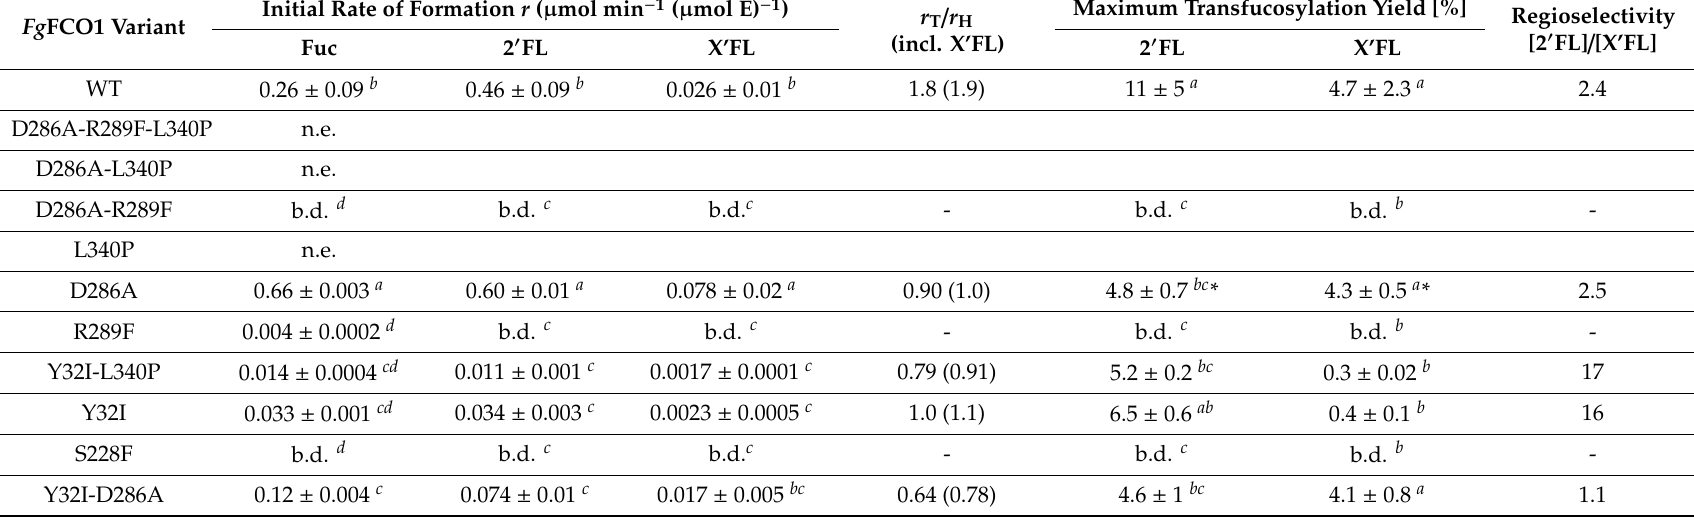
Table 2. Transfucosylation with rationally designed variants of Fg FCO1. Initial rates of formation ( r ) of fucose (Fuc), 2 (cid:48) -fucosyllactose (2 (cid:48) FL), and its regioisomer X’FL in the transfucosylation catalyzed by Fg FCO1 variants using fucosylated citrus peel xyloglucan as the fucosyl donor and lactose as the acceptor over 24 h. The ratio between the transfucosylation rate ( r T ) and the hydrolysis rate ( r H ) is indicated: the first number is calculated for 2’FL alone, whereas the number in brackets includes the sum of FL isomers. Maximum molar yields on the donor substrate obtained during the 24 h of reaction are given for 2 (cid:48) FL and X’FLA few enzyme variants could not be expressed in detectable amounts (n.e.). For some enzyme variants, activity was below the HPAEC-PAD detection limit (b.d.) of 0.05 µ M product, which equals a product yield of 0.0025%; these numbers were included in the statistical analysis. Superscript letters ( a – d ) indicate significant di ff erences between enzyme variants for each rate of formation or for the yield of each product ( p < 0.05). Regioselectivity ([2 (cid:48) FL] / [X’FL]) is calculated at the highest yield of 2 (cid:48)